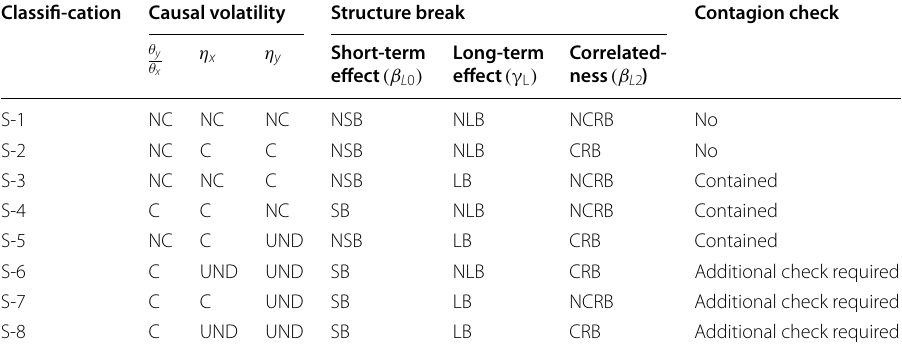
Table 1 Contagion dynamics